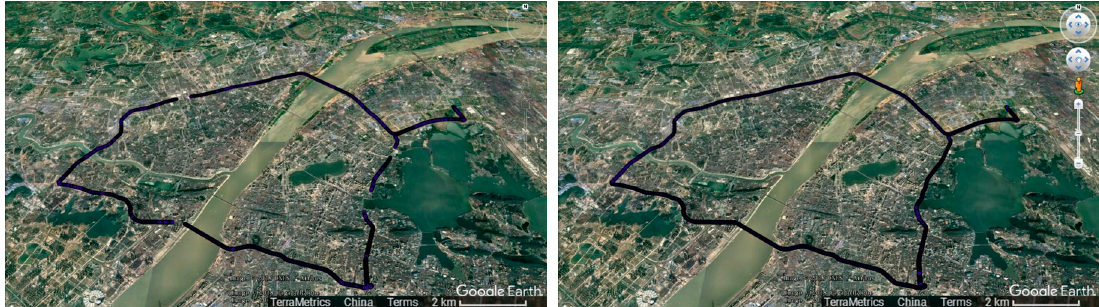
Figure 4. The whole vehicle trajectory on the 2nd Ring Rd; (The left one is obtained from GNSS, the right one is obtained from GNSS/INS).